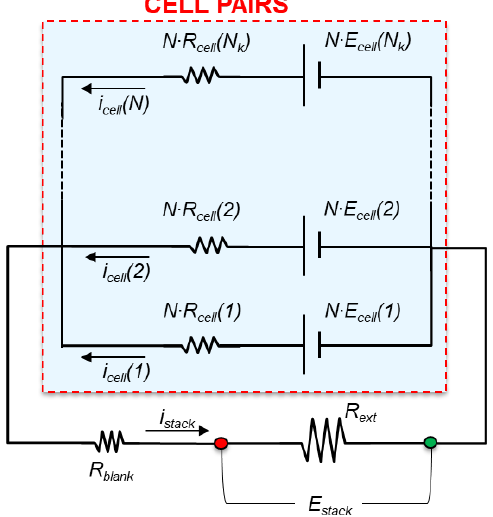
Figure 4. Equivalent electric circuit of the RED unit.